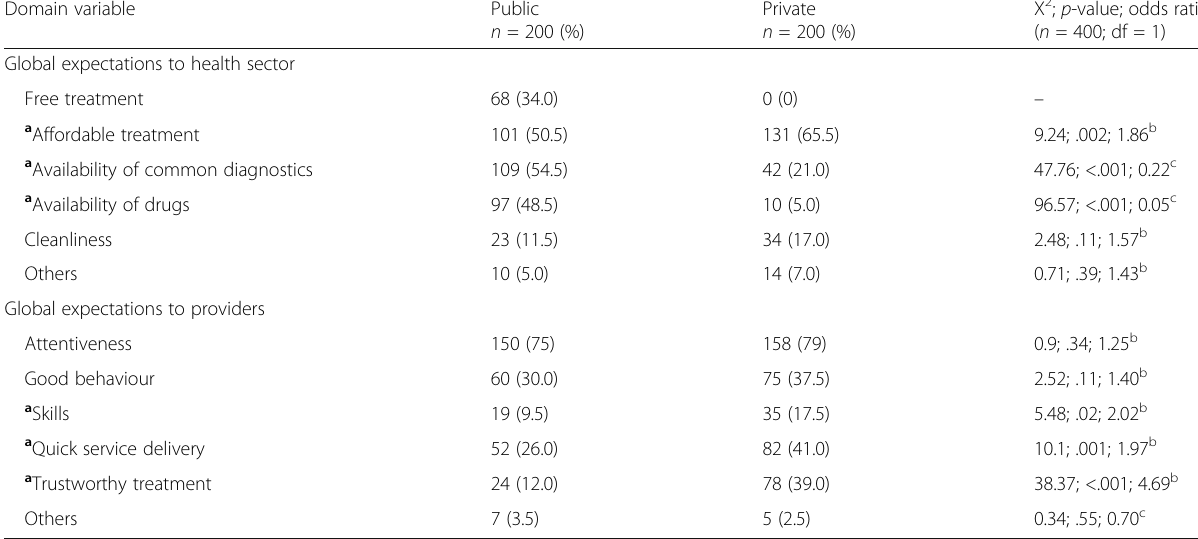
Table 4 Frequencies of clients ’ global expectations to the health system and providers with chi-square statistics Domain variable Public